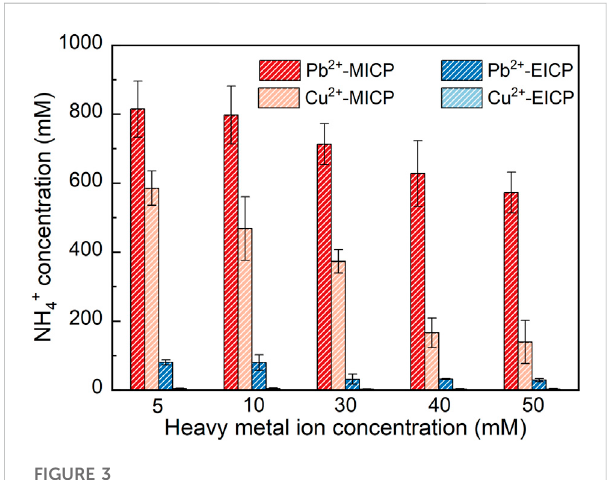
FIGURE 4 Relationships of precipitation mass versus Pb 2+ or Cu 2+ concentration under MICP and EICP